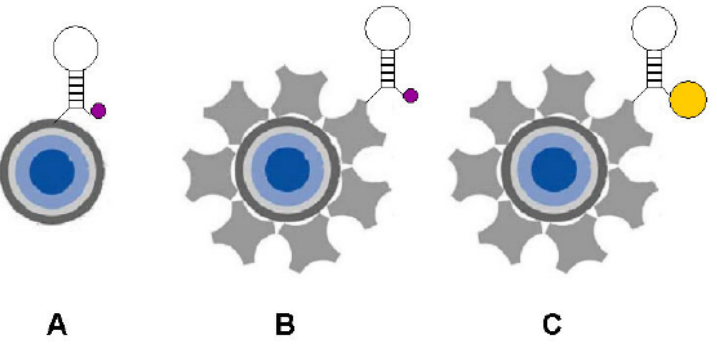
Figure 7. A representation of the three different quantum dot molecular beacon labeling strategies is shown. Carboxyl-modified quantum dots (blue core) were modified with amino-labeled molecular beacons (A) while streptavidin modified quantum dots (blue core dot with surrounding gray streptavidin molecules) were modified with biotin-labeled molecular beacons. Both dabcyl and Iowa Black FQ quenchers (small purple circles) were used, as well as 1.4nm Nanogold (gold colored circle), (reprinted with permission